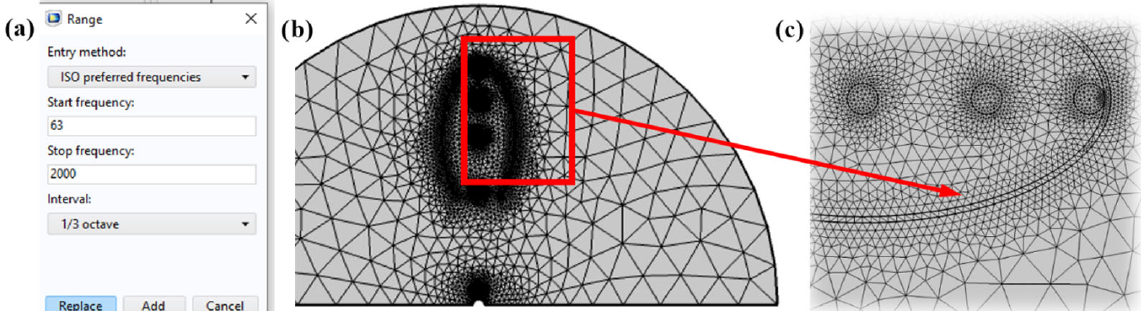
Figure 2. Meshed model: ( a ) menu for defining the studied frequency range at third-octaves; ( b ) general view of the model mesh; ( c ) model mesh in the area of the elliptical sector.